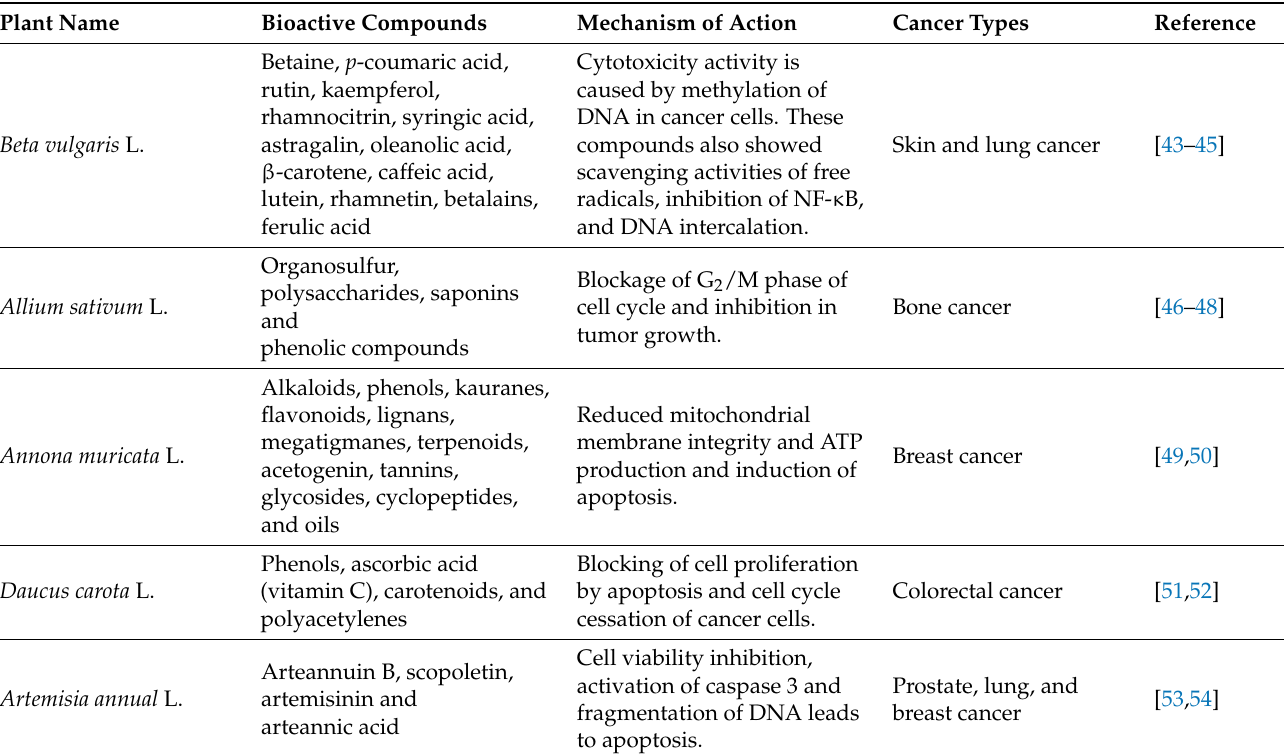
Table 2. Exemplary the Medicinal Plants and Its Bioactive